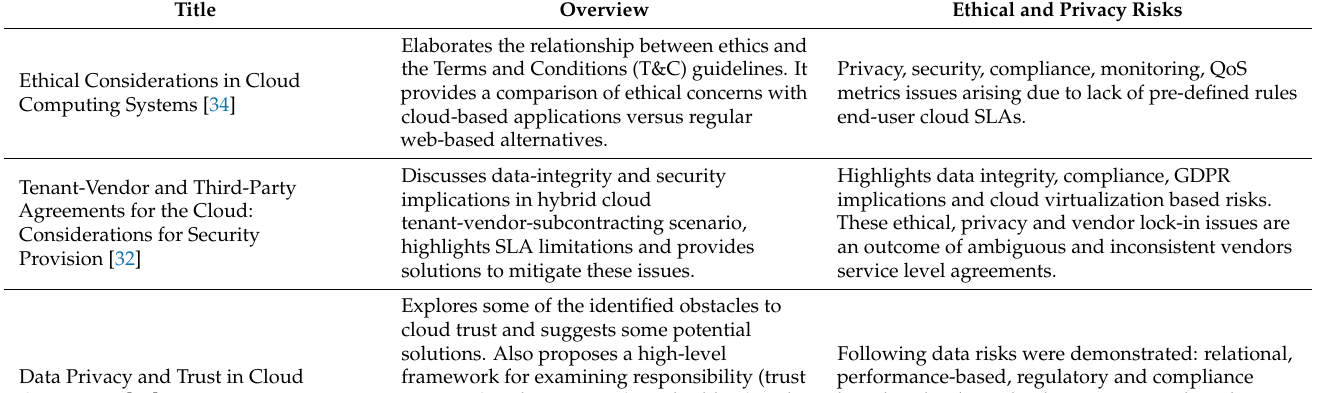
Table 2. Ethics and privacy in Cloud Computing.